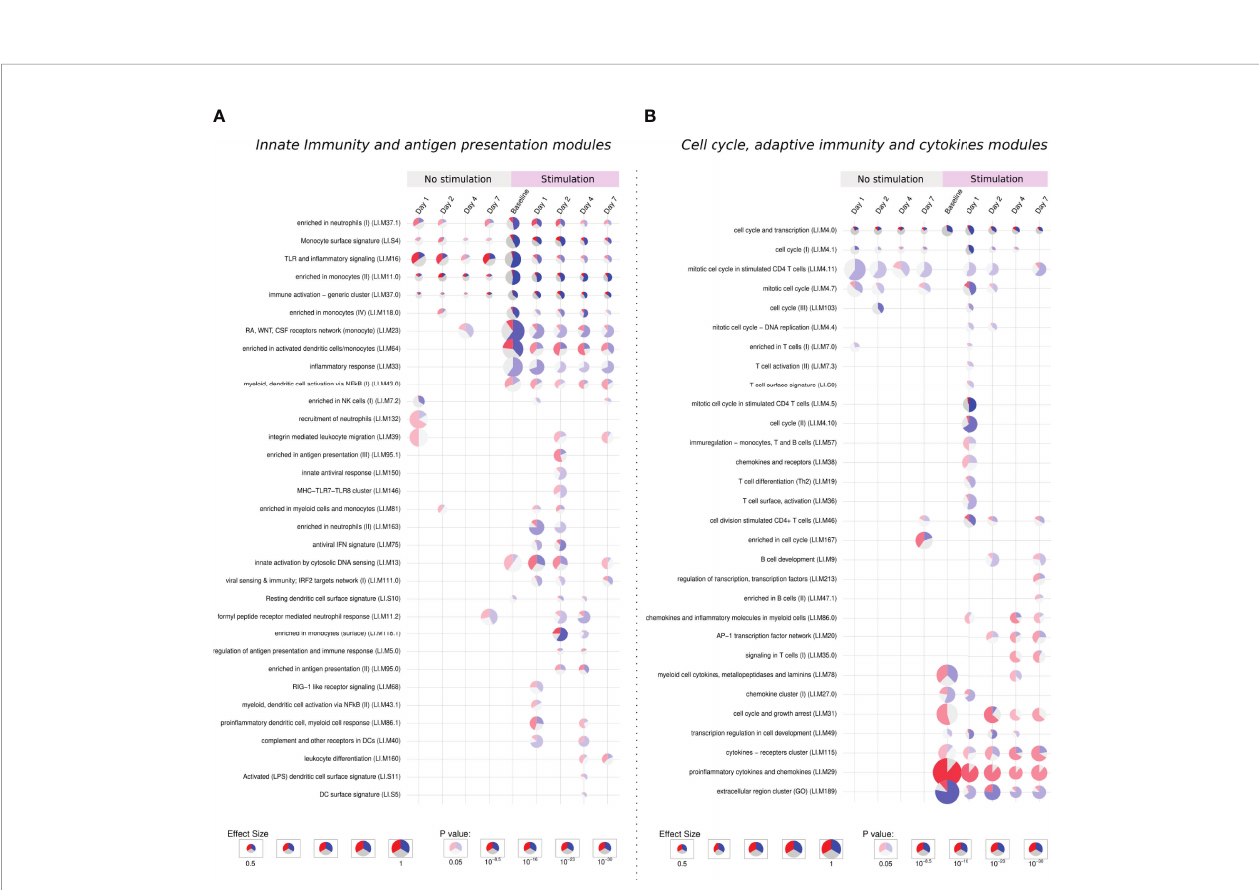
FIGURE 5 | Tmod enrichment analysis. From the list of genes provided by the DESeq2 package, genes were selected by their FDR value (< 0.05) and absolute log2 Fold Change (> 0.5). The enriched blood transcription modules were obtained by the Hypergeometric test. (A) Modules related to innate immunity and antigen presentation, (B) modules related to cell cycle, adaptive immunity and cytokines modules. The effect size is proportional to the size of the pie, while the adjusted p- value is proportional to colour intensity. Within each pie, the proportion of signi fi cantly upregulated and downregulated genes is shown in red and blue, respectively. The gray portion of the pie represents genes that are not signi fi cantly differentially regulated.